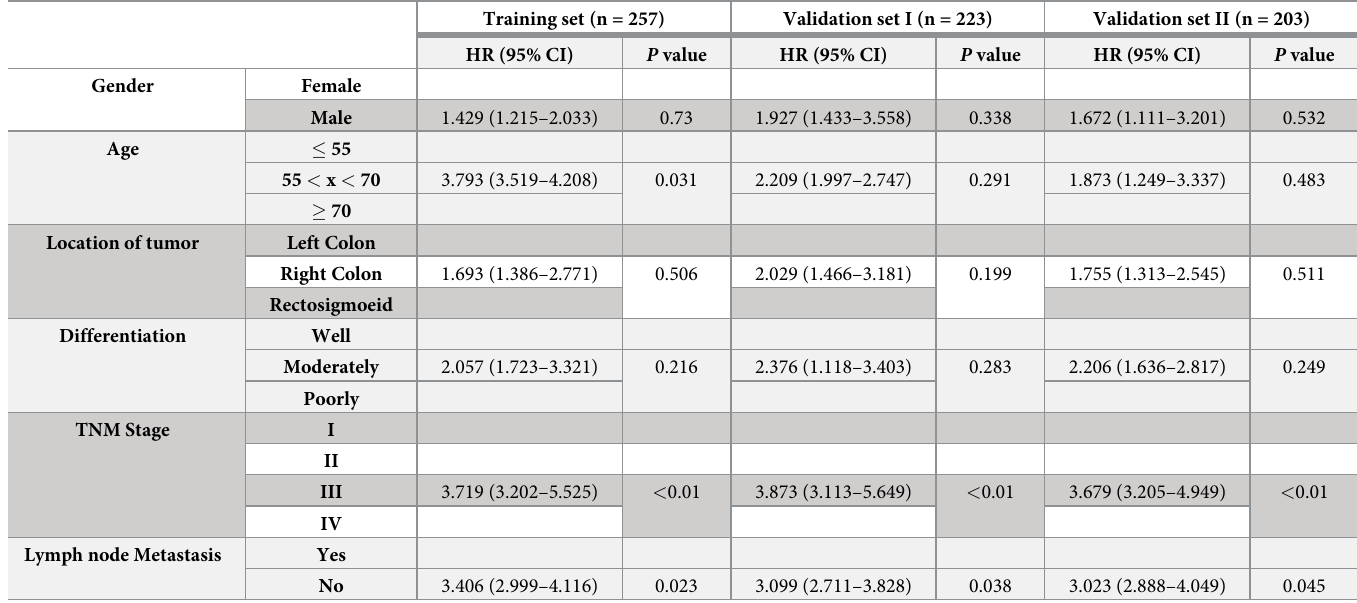
Table 4. Univariate Cox regression analysis of overall survival of the clinical variables in CRC patients.